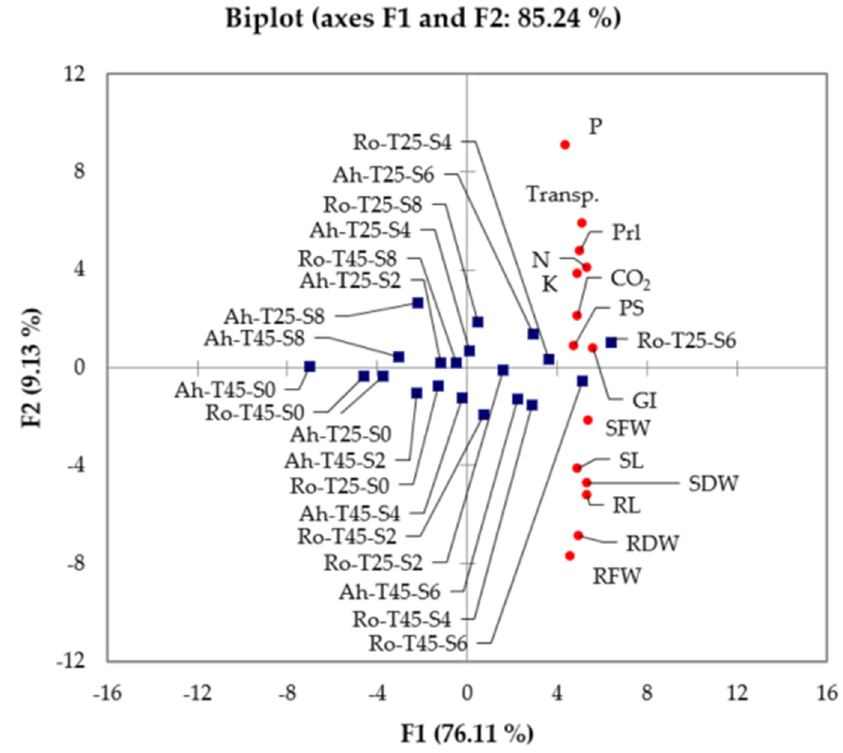
Figure 9. Principal component analysis of sulfur treatments and various morphological, physiological, and biochemical variables of tomato cultivars Ahmad and Roma. Abbreviations: